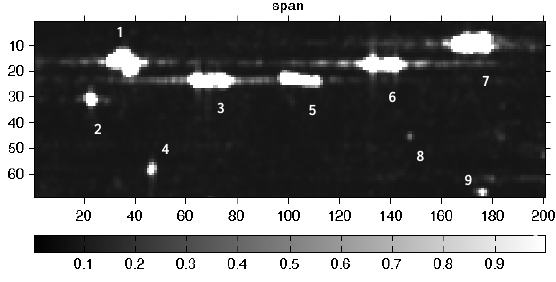
Figure 5. The span image of SIR-C SAR on 4 th Oct.1994.